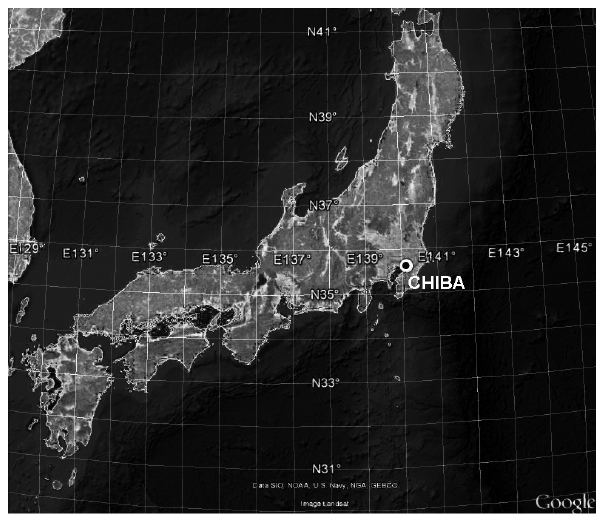
Fig. 1. Geographical position of the Chiba station in